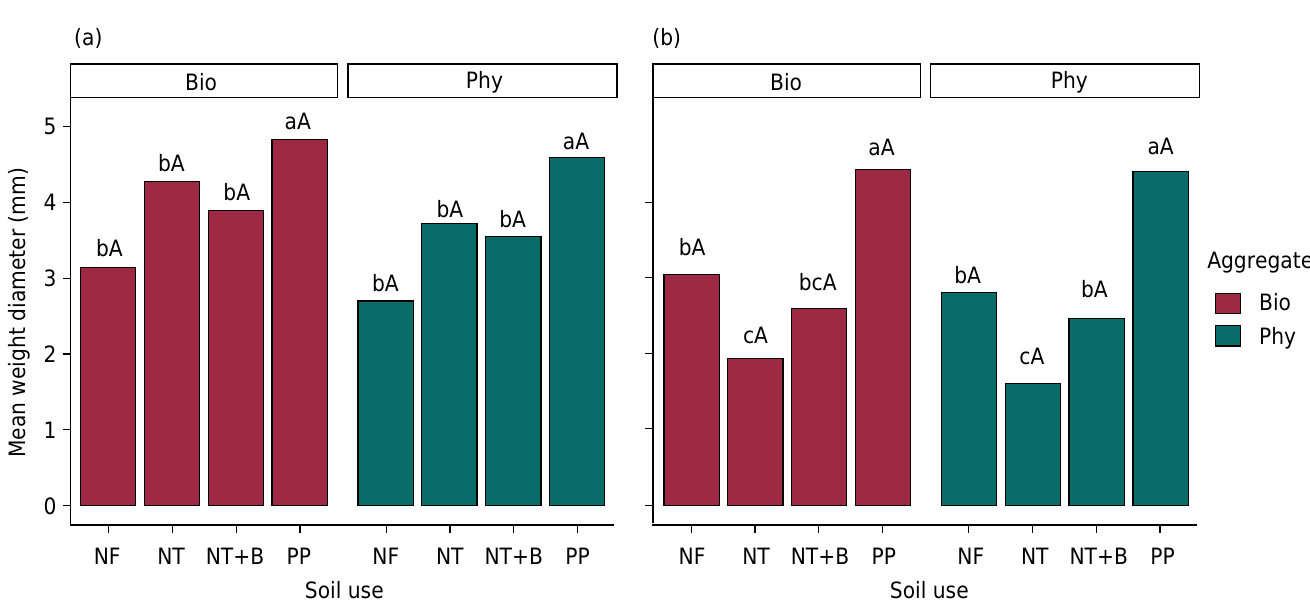
Figure 2. Mean weight diameter (MWD) of biogenic (Bio) and physicogenic (Phy) aggregates from areas under management systems in the subtropical region of Brazil. Means followed by the same lower-case letter do not differ between management systems for the same type of aggregate. Means followed by the same capital letter in the row do not differ among the types of aggregates for the same evaluated system (ANOVA + Tukey’s test without data transformations; ANOVA + Tukey’s test with data transformations; and Kruskal-Wallis test + Fisher’s minimum significant difference). (a) 0.00-0.05 m soil layer; and (b) 0.05-0.10 m soil layer. PP: Permanent pasture; NT: No-tillage system; NT+B: No-tillage + Brachiaria system; and NF: Atlantic Forest biome